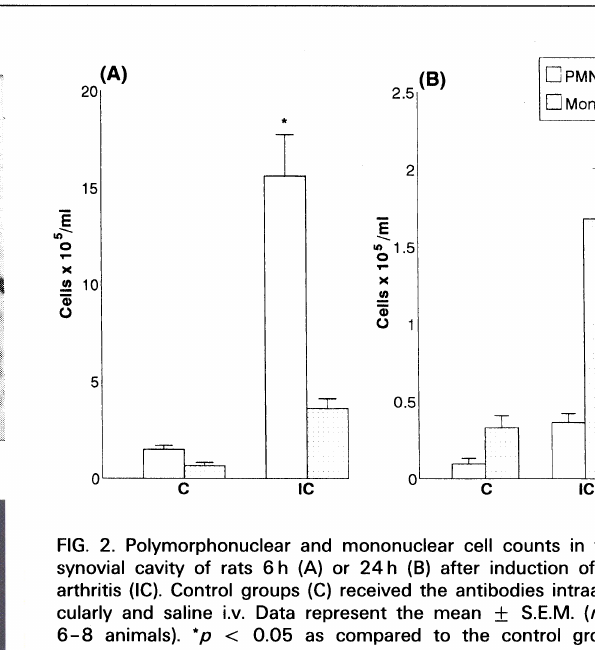
FIG. 2. Polymorphonuclear and mononuclear cell counts in the synovial cavity of rats 6h (A) or 24h (B) after induction of IC arthritis (IC). Control groups (C) received the antibodies intraarti- cularly and saline i.v. Data represent the mean 6-8 animals). *p < 0.05 as compared to the control group using Student’s